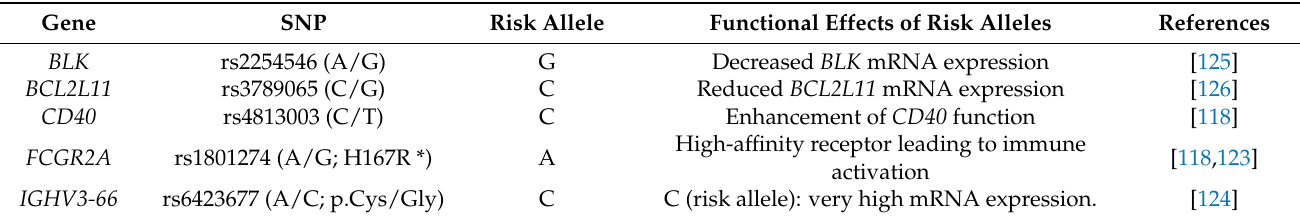
Table 5. Functional effects of risk alleles of KD susceptibility genes. Functional Effects of Risk